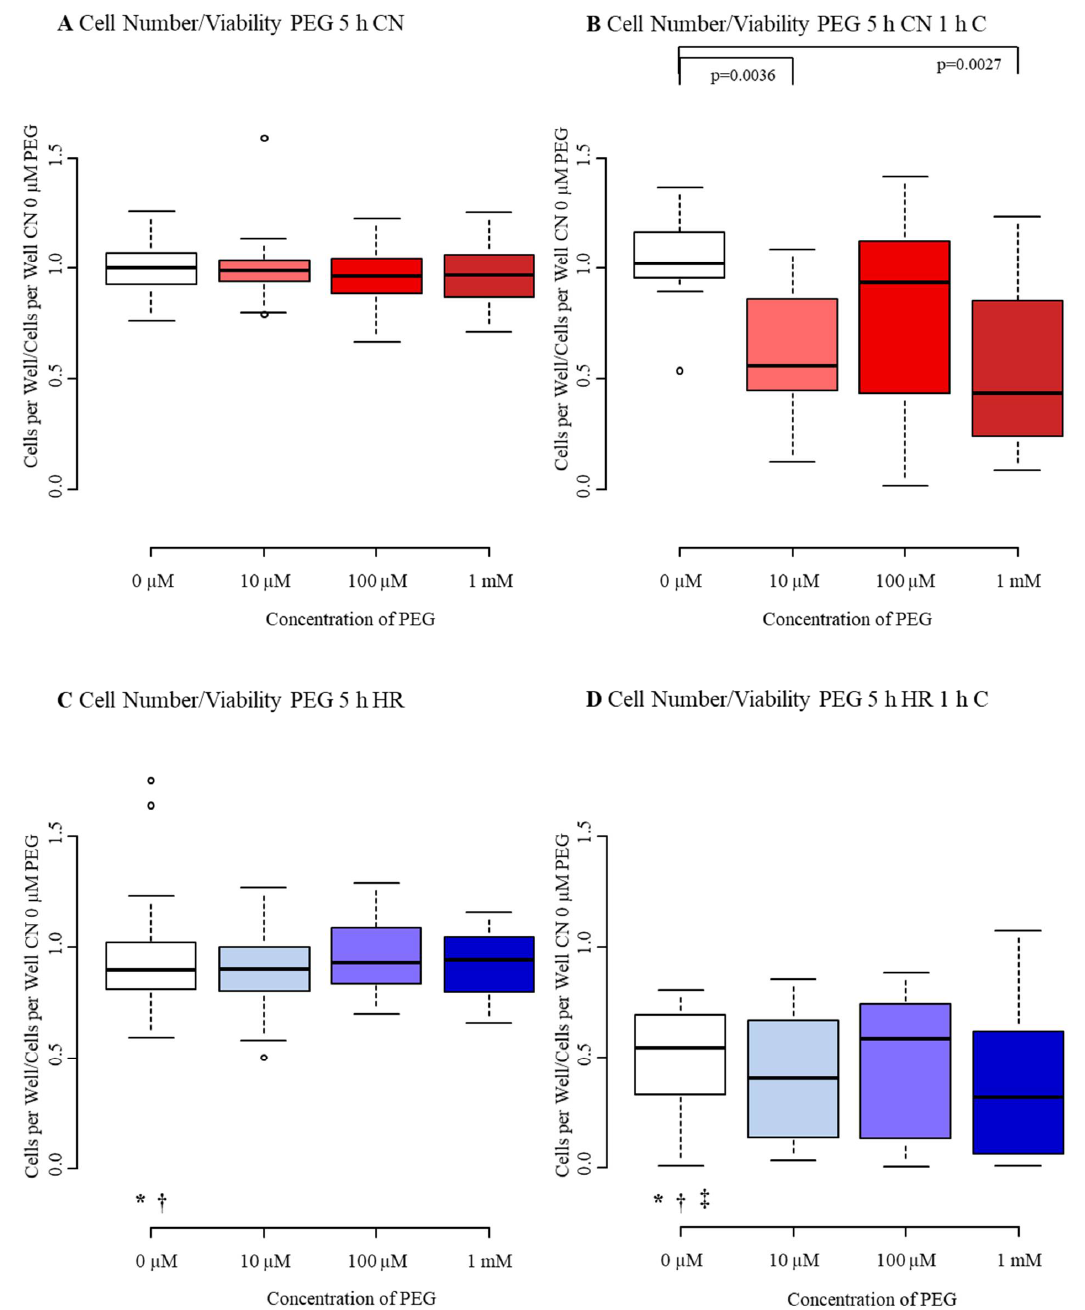
Figure A4. Cell number/viability after 5 h injury and treatment with 0 µ M, 10 µ M, 100 µ M, and 1 mM of PEG. ( A ) normoxia (CN-C); ( B ) normoxia and 1 h compression (CN+C); ( C ) hypoxia (HR-C); ( D ) hypoxia and 1 h compression (HR+C).